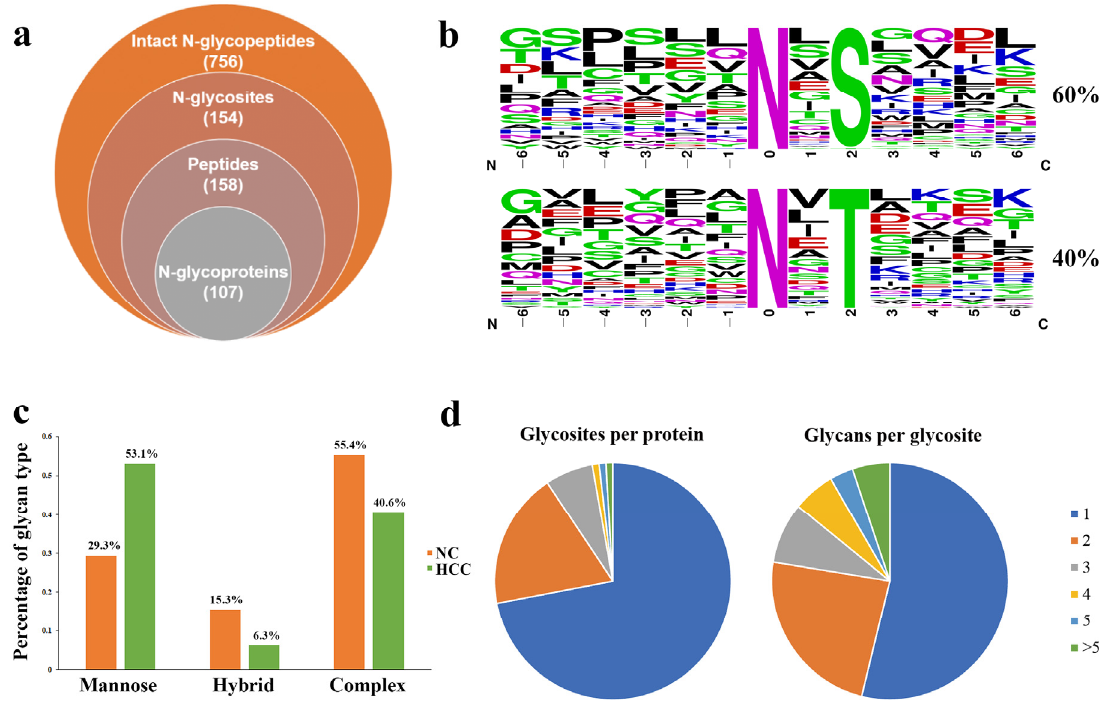
Figure 3. Identification and distribution of intact N-glycopeptides in urinary EVs from patients with HCC relative to NC. ( a )The identified intact N-glycopeptide IDs (FDR ≤ 1%). ( b ) Sequence motifs for N-glycosites having either the N-XS or N-X-T sequon and their relative percentage in the unique Nglycosites identified. ( c ) The percentage of each N-glycan type in urinary EVs from patients with HCC and NC. ( d ) Distribution of glycosites ( left ) and glycans per glycosite ( right ) of the identified glycoproteins. Table 1. The intact N-glycopeptides identified from probable serine carboxypeptidase CPVL (Q9H3G5, CPVL_HUMAN) modified with N2H5F0S0 on N-glycosites N81, N307 and N346 and N2H4F0S0 and N2H6F0S0 on the N-glycosite N81 and N346 as well as N2H3F0S0 and N2H4F1S0 on N-glycosite 346.